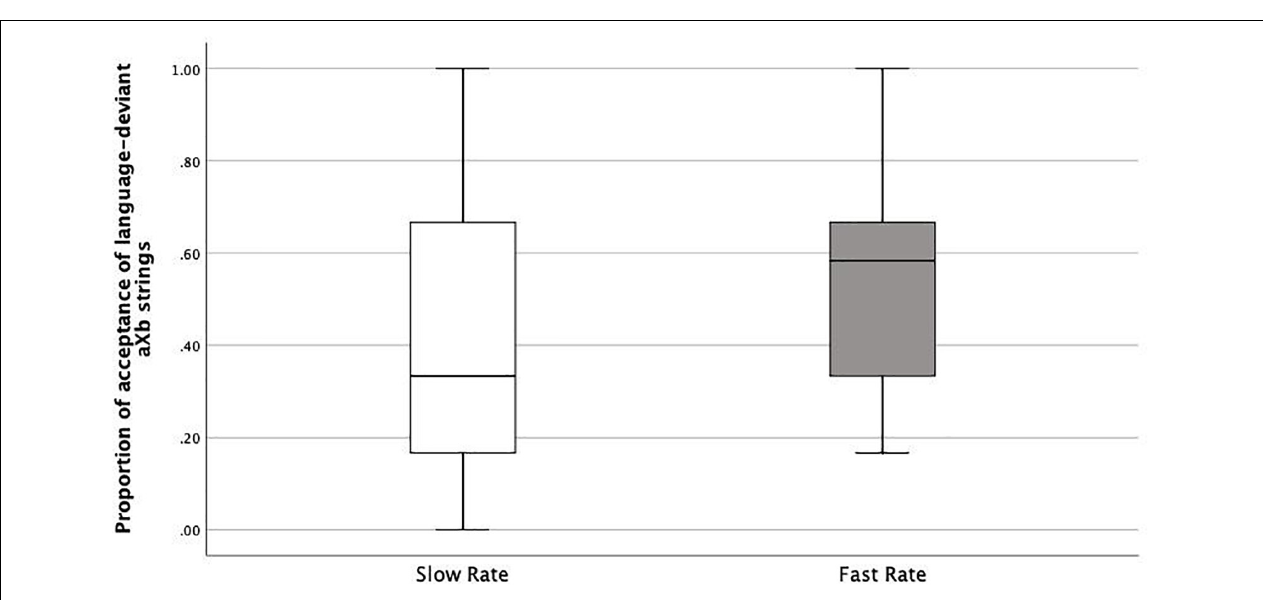
FIGURE 7 | Boxplots of proportions of acceptance of language-deviant aXb strings in Slow Rate Condition as compared to Fast Rate